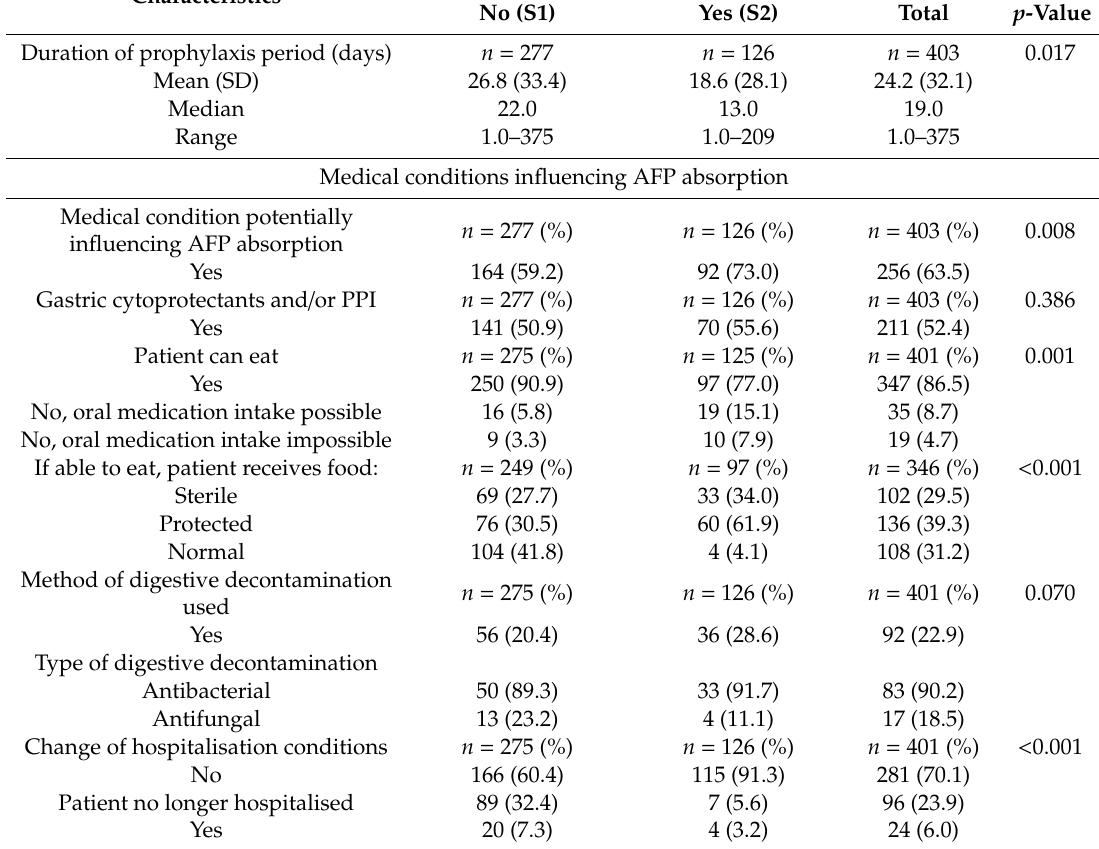
Table 5. End of antifungal